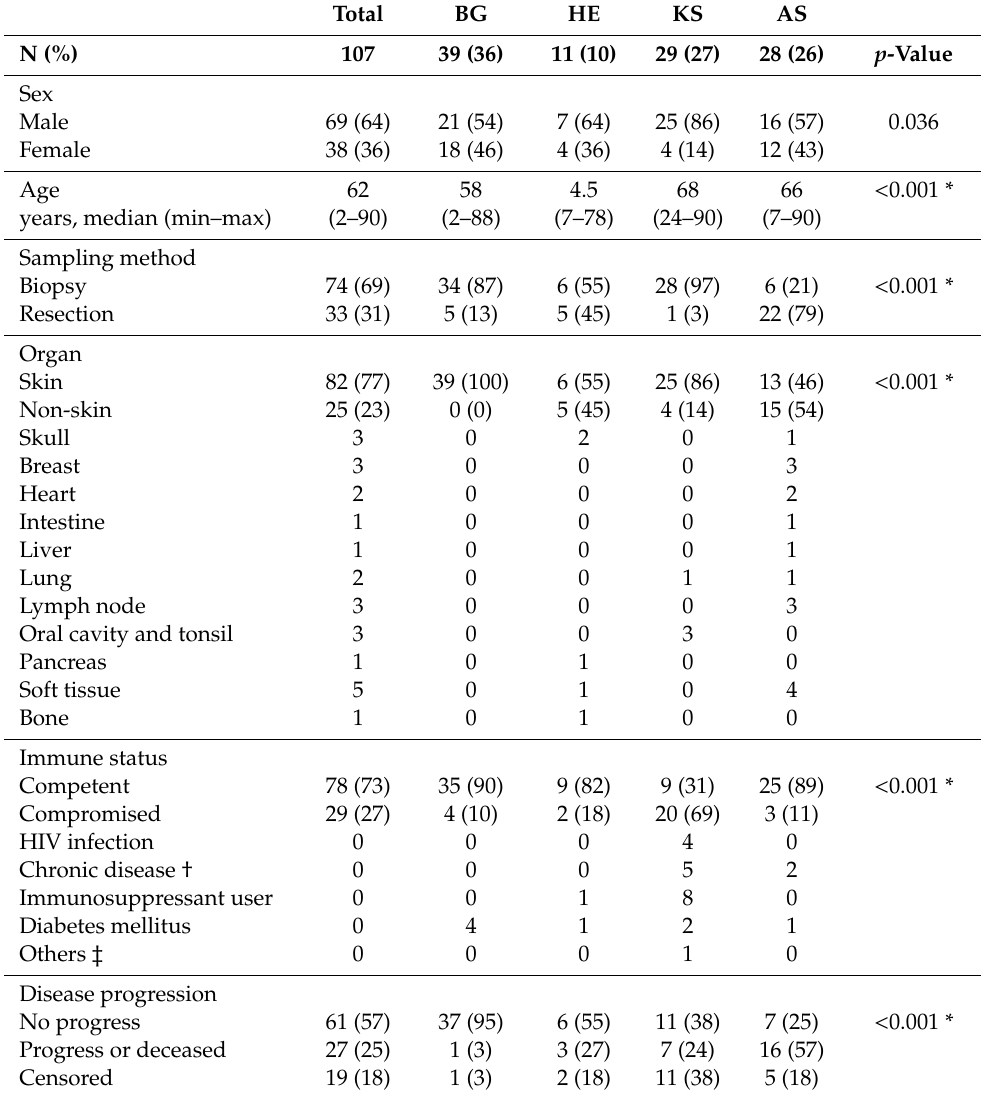
Table 4. Demography of 107 patients according to disease